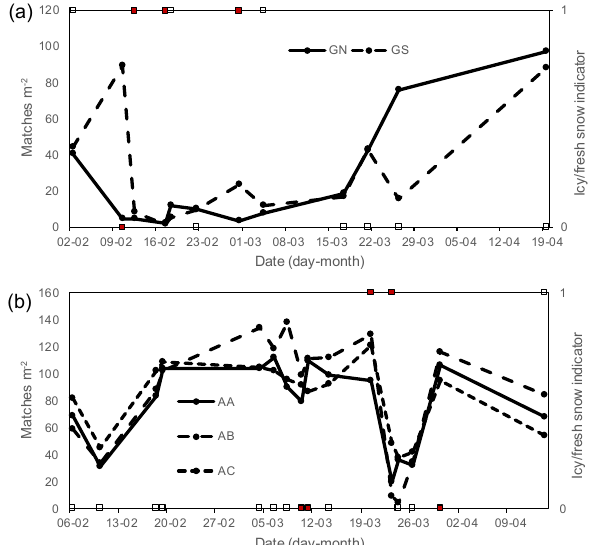
Figure 3. Pix4D automated key point match density for (a) Gatineau and (b) Acadia together with an indicator of fresh snow (square symbols). Missions (solid circular symbols) for the same site are connected by lines. Red squares indicated overcast conditions.